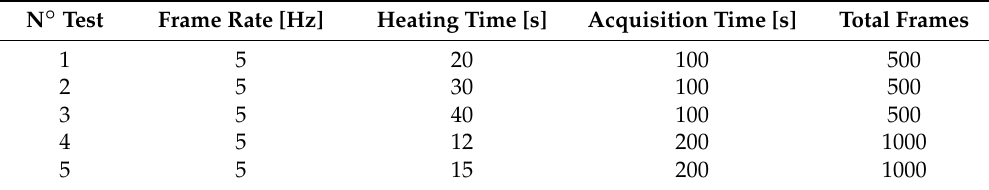
Table 5. Scheduling tests for the multi-stringer component’s